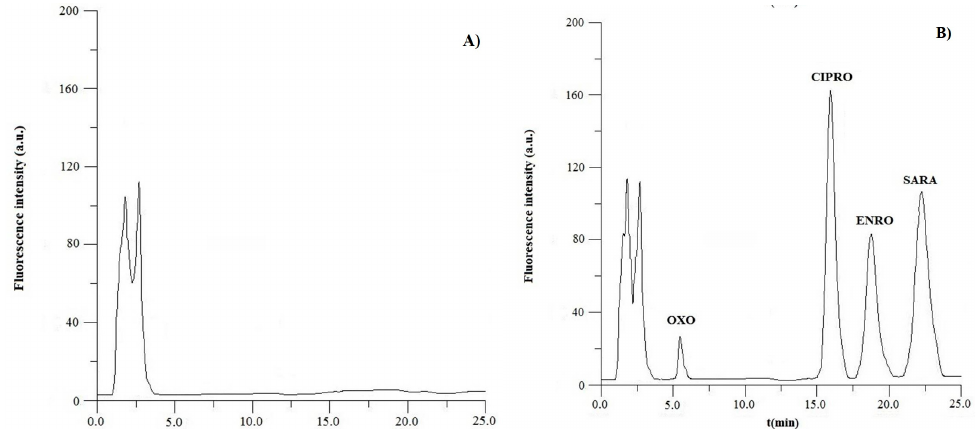
Figure 1. Chromatograms obtained by analysis of a sample of fresh egg yolk: ( A ) blank and ( B ) fortified with 0.5 mg/kg of each quinolone.